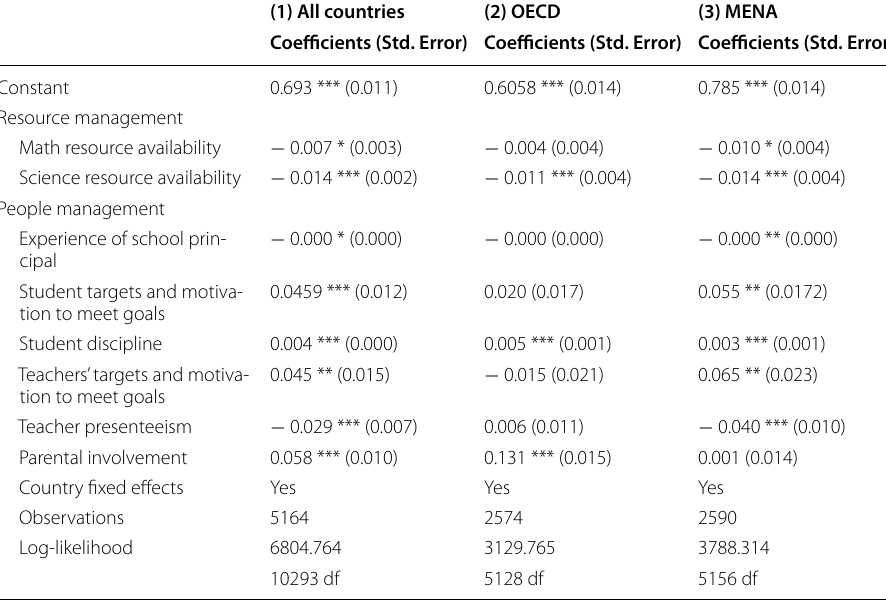
The table reports the estimates of Tobit regression for the entire sample of schools in MENA and OECD countries in TIMSS 2019 with input-oriented technical efficiency taken as the dependent